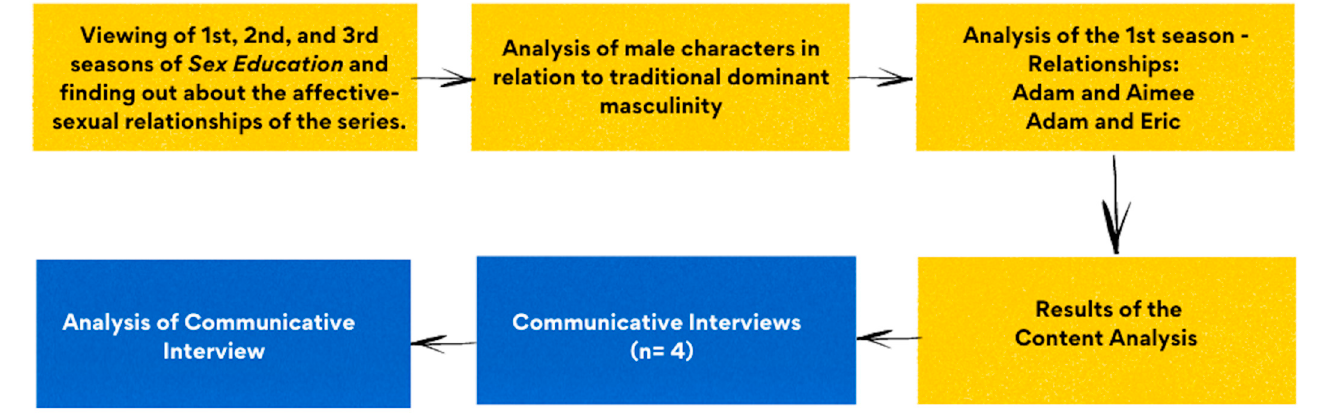
Figure 1. Flowchart of the Data Collection and Analysis